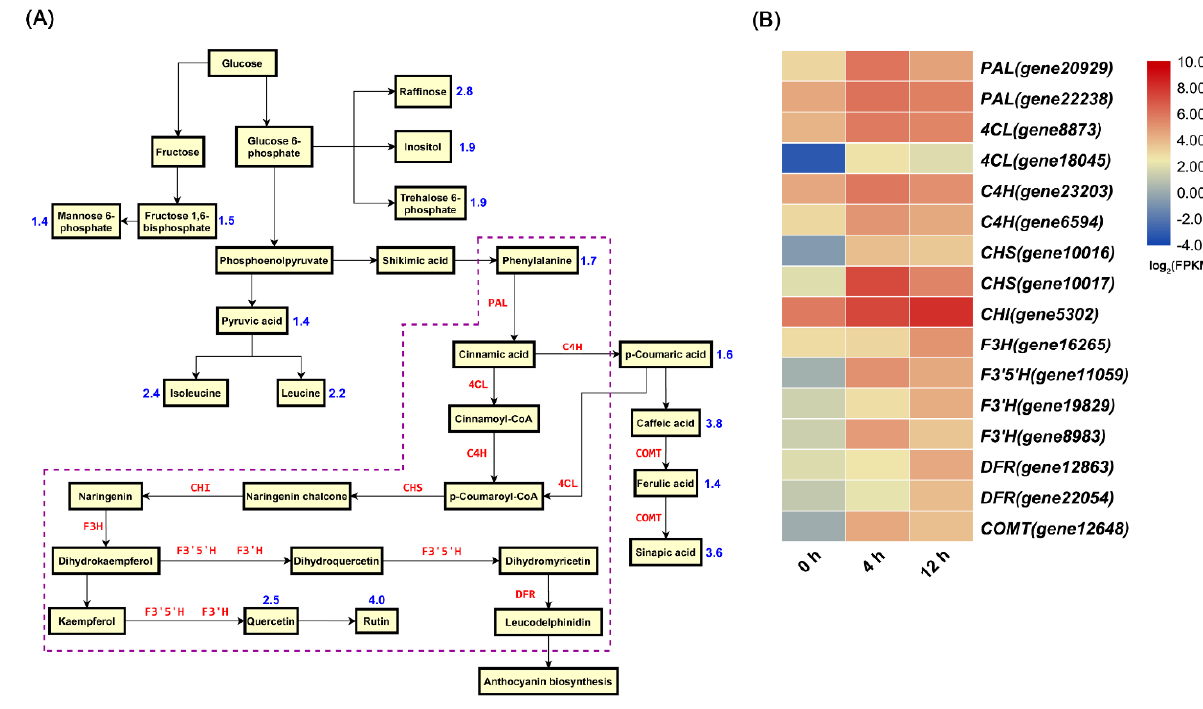
Figure 5. Sugar, amino acid, and flavonoid metabolic pathways and related upregulated genes under salt stress. ( A ) Sugar, amino acids, and flavonoid metabolic pathways. Blue text shows the value of log 2 fold change (FC) in metabolites under salt stress (see Table S5 for details). ( B ) Heat map analysis of upregulated gene expression under salt